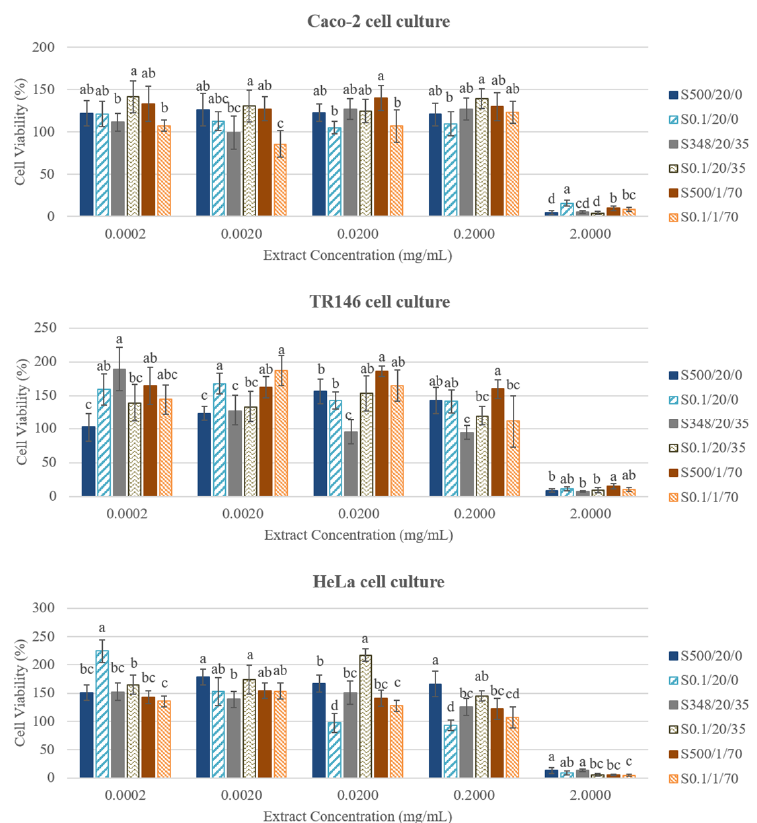
Figure 3. Results of cell viability in percentage, obtained for the six extracts of S. montana with Caco-2, TR146, and HeLa cell culture lines. Different letters indicate significant differences ( p < 0.05) between extracts for each concentration studied (0.0002 to 2.000 mg/mL).